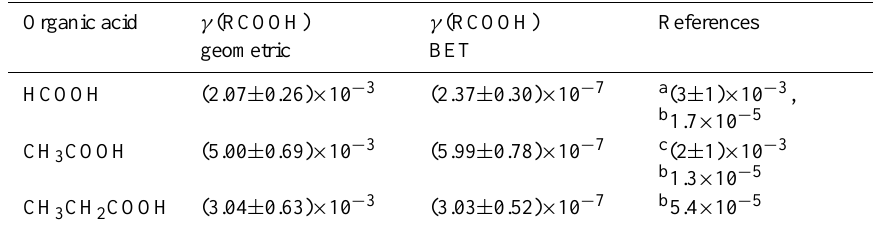
Table 1. Summary of the reactive uptake coefficients obtained for the uptake of three organic acids on α -Al 2 O 3 particles at T =300K using DRIFTS